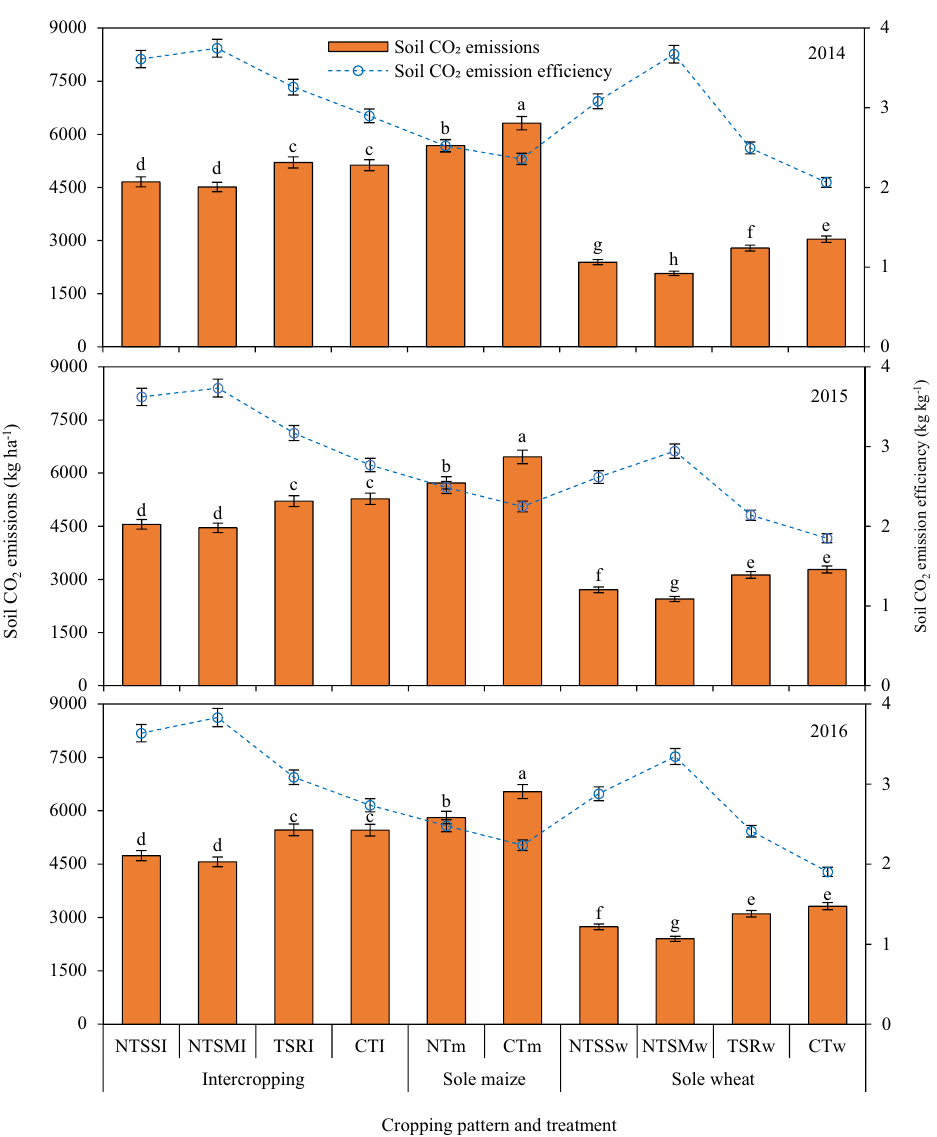
Figure 3. Effect of different straw returning and film mulching on soil CO 2 emission and soil CO 2 emission efficiency of maize and wheat in sole patterns and intercropping patterns in 2014–2016. The different letters are significantly different at 0.05 probability level, and the error bars indicate the standard errors of the means (n = 3). The descriptions of the treatment codes are given in Table